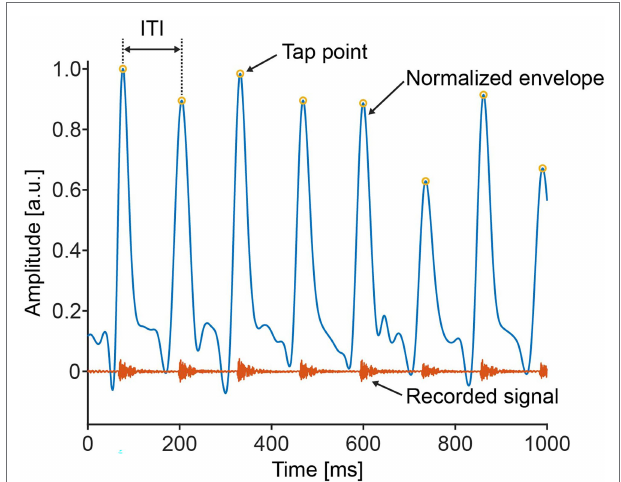
FIGURE 2 | A typical example of the recorded sound signal. The envelope of the recorded signal was calculated and the amplitude was normalized by the maximum value. The “tap points” were detected from the envelope signal. The inter-tap intervals (ITI) were calculated as the interval between the two sequential tap